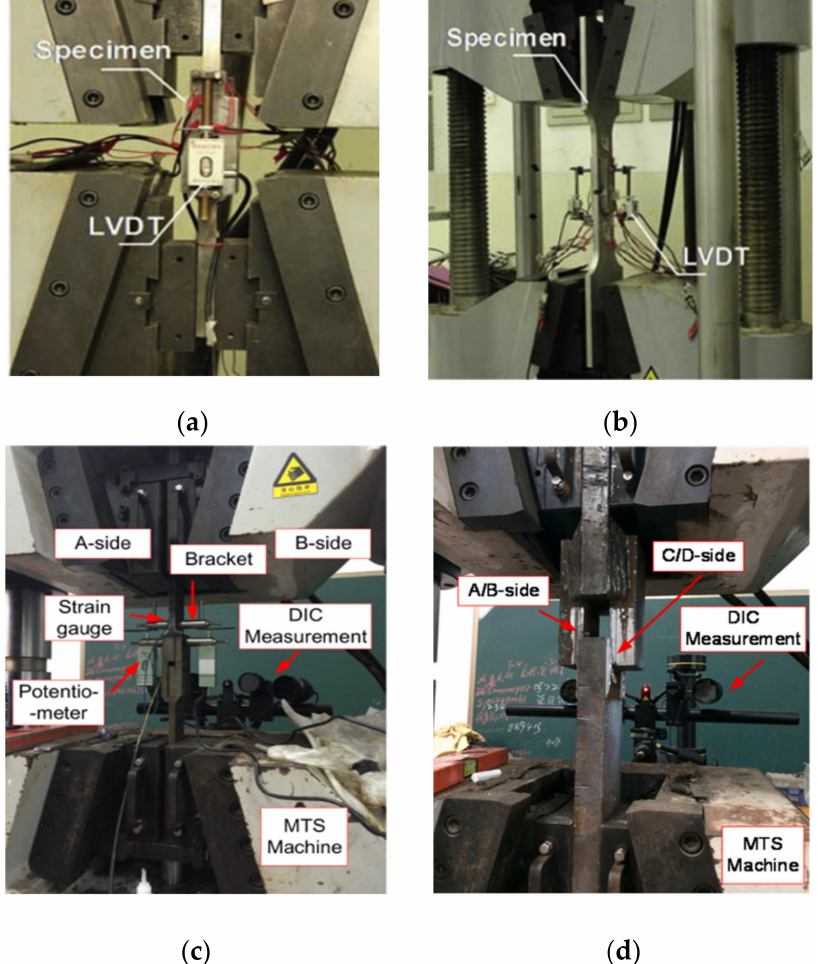
Figure 7. Experimental setup for fillet welded joints (used with permission, Elsevier [30,33]). ( a ) Trans- verse fillet welded joint; ( b ) Longitudinal fillet welded joint; ( c ) Transverse fillet welded joint; ( d ) Lon- gitudinal fillet welded